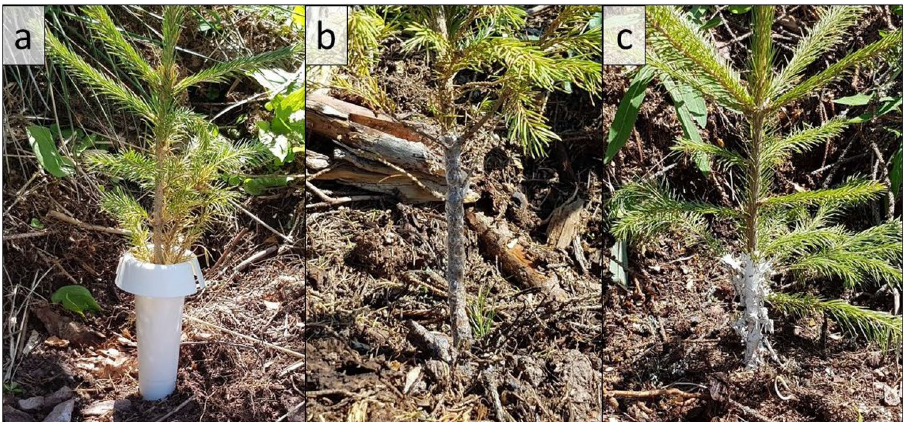
Figure 1. Spruce seedlings treated with ( a ) Hylopro, ( b ) Vermifix, and ( c ) Eco-wax.